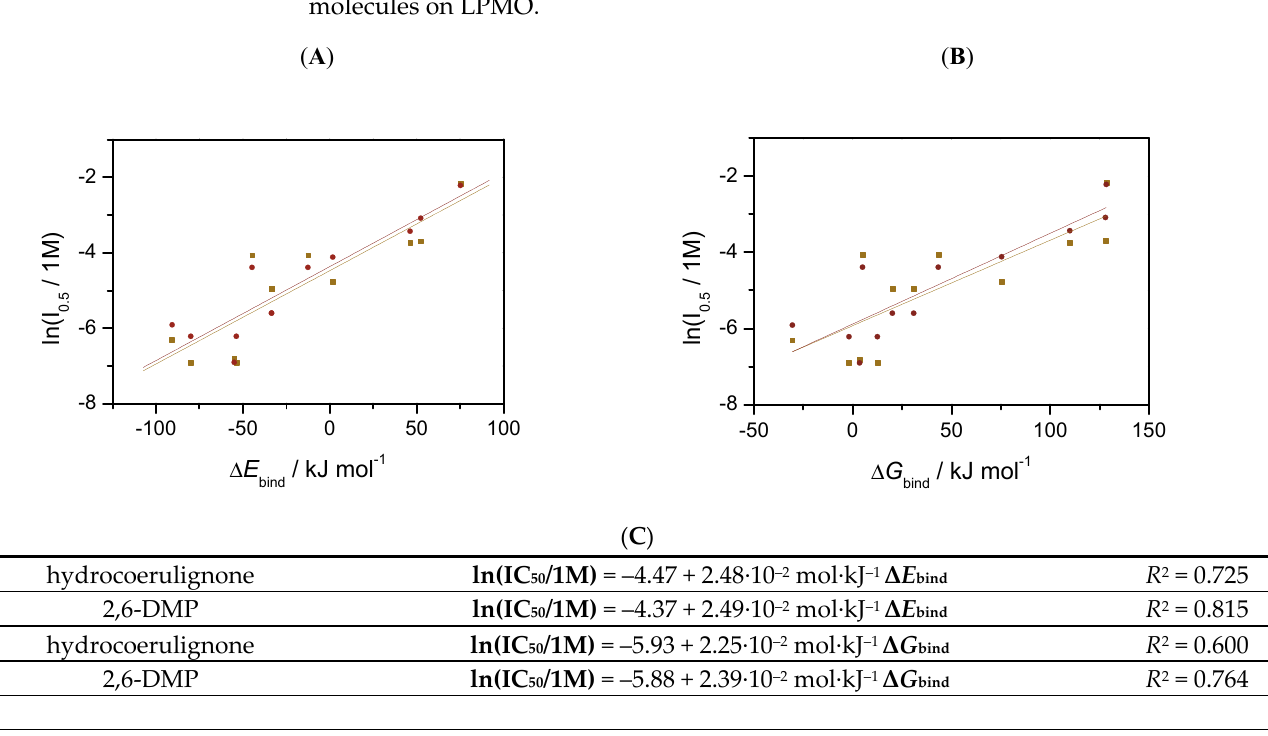
Figure 8. The dependence of the logarithm of IC 50 on the ( A ) binding energies and ( B ) binding free energies with 2,6-DMP (circles) or hydrocoerulignone (squares) as substrates. ( C ) Equations of the dependence between ln(IC 50 ), Δ E bind and Δ G bind .